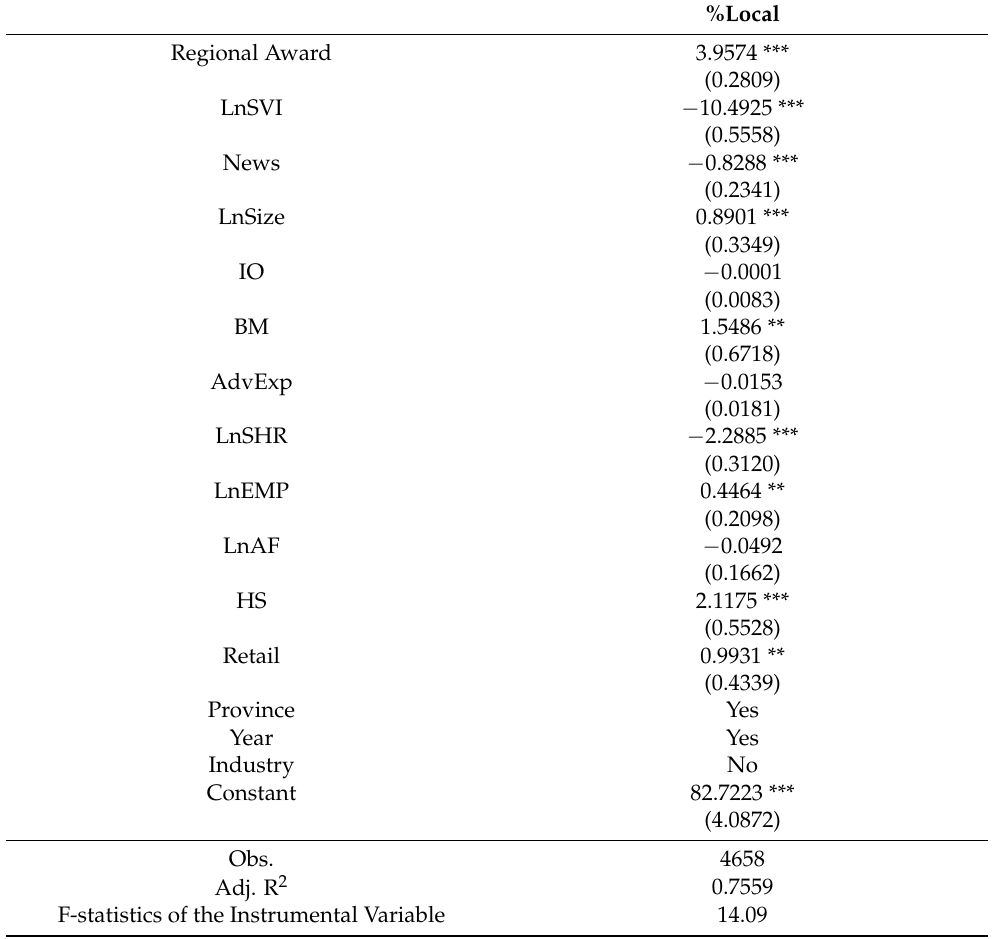
Table 8. First-Stage Regression Results.